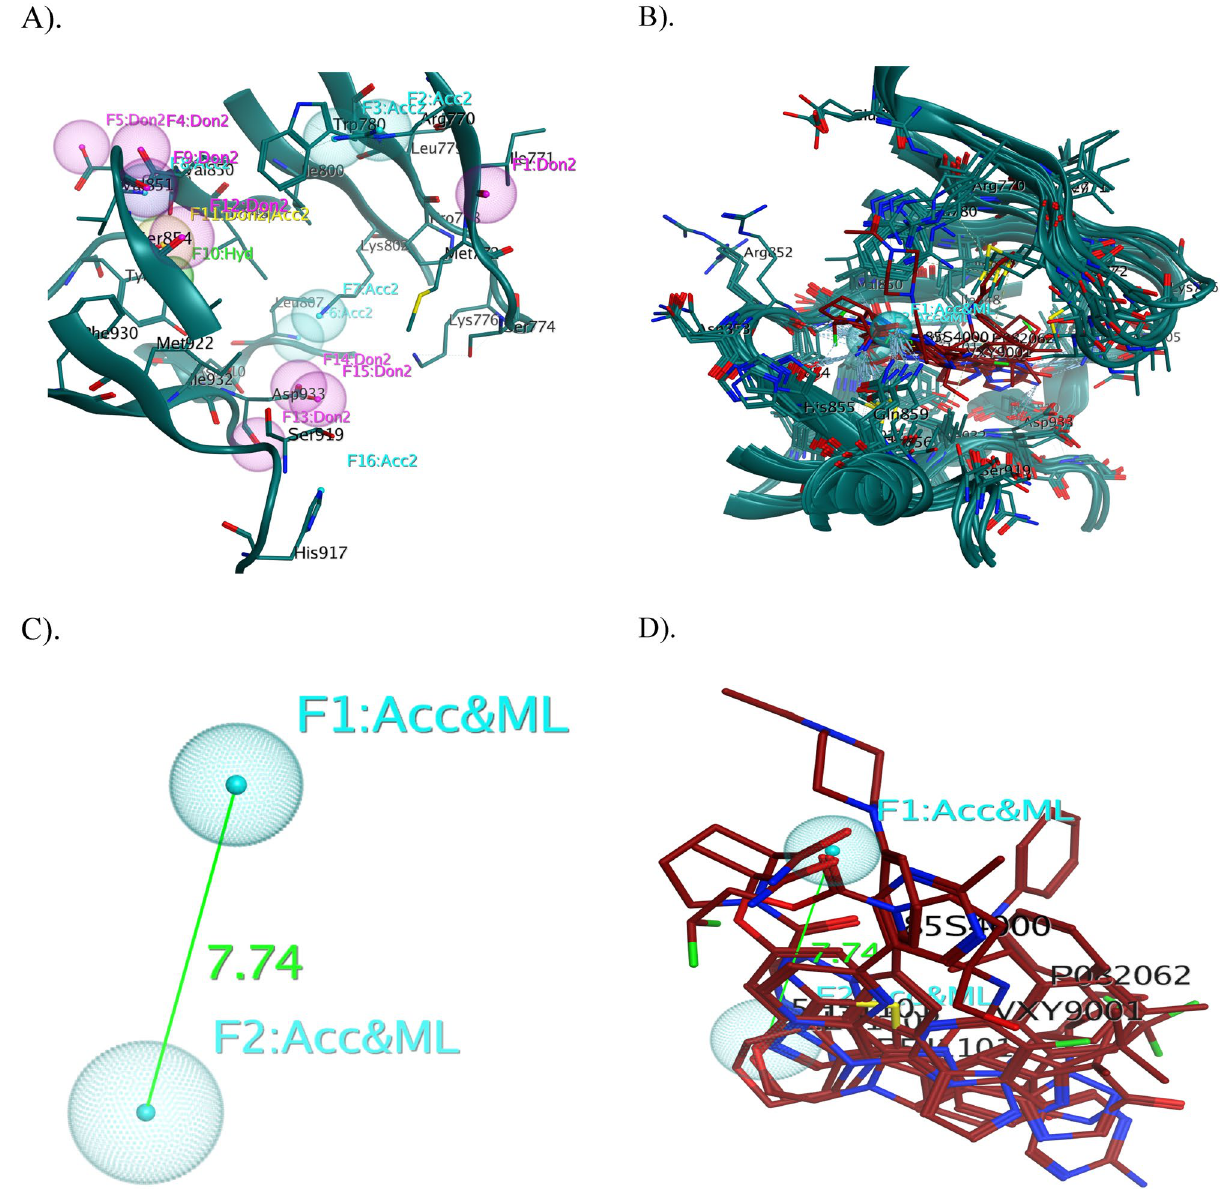
Figure 3. . (A) 3D pharmacophore annotation of ATP binding pocket of PI3K-α, (B) Overlay of crystal structures of PI3K-α co-crystalized with different ligands and generated 3D spatial arrangement of pharmacophore features with vector projections in the binding cavity of PI3K-α, (C) The distance constraints were calculated between the vital features, and (D) The co-crystalized ligands of PI3K-α were superimposed and aligned with the generated pharmacophore query. The proteins are shown in the cartoon and the key residues in the binding cavity indicate the sticks with labeling and the ligands are indicated in red colour. (Don & Acc: hydrogen bond donor/acceptor, Aro: aromatic center, Don: hydrogen bond donor, Acc: hydrogen bond acceptor, Hyd: hydrophobic, Cat & Don: cation